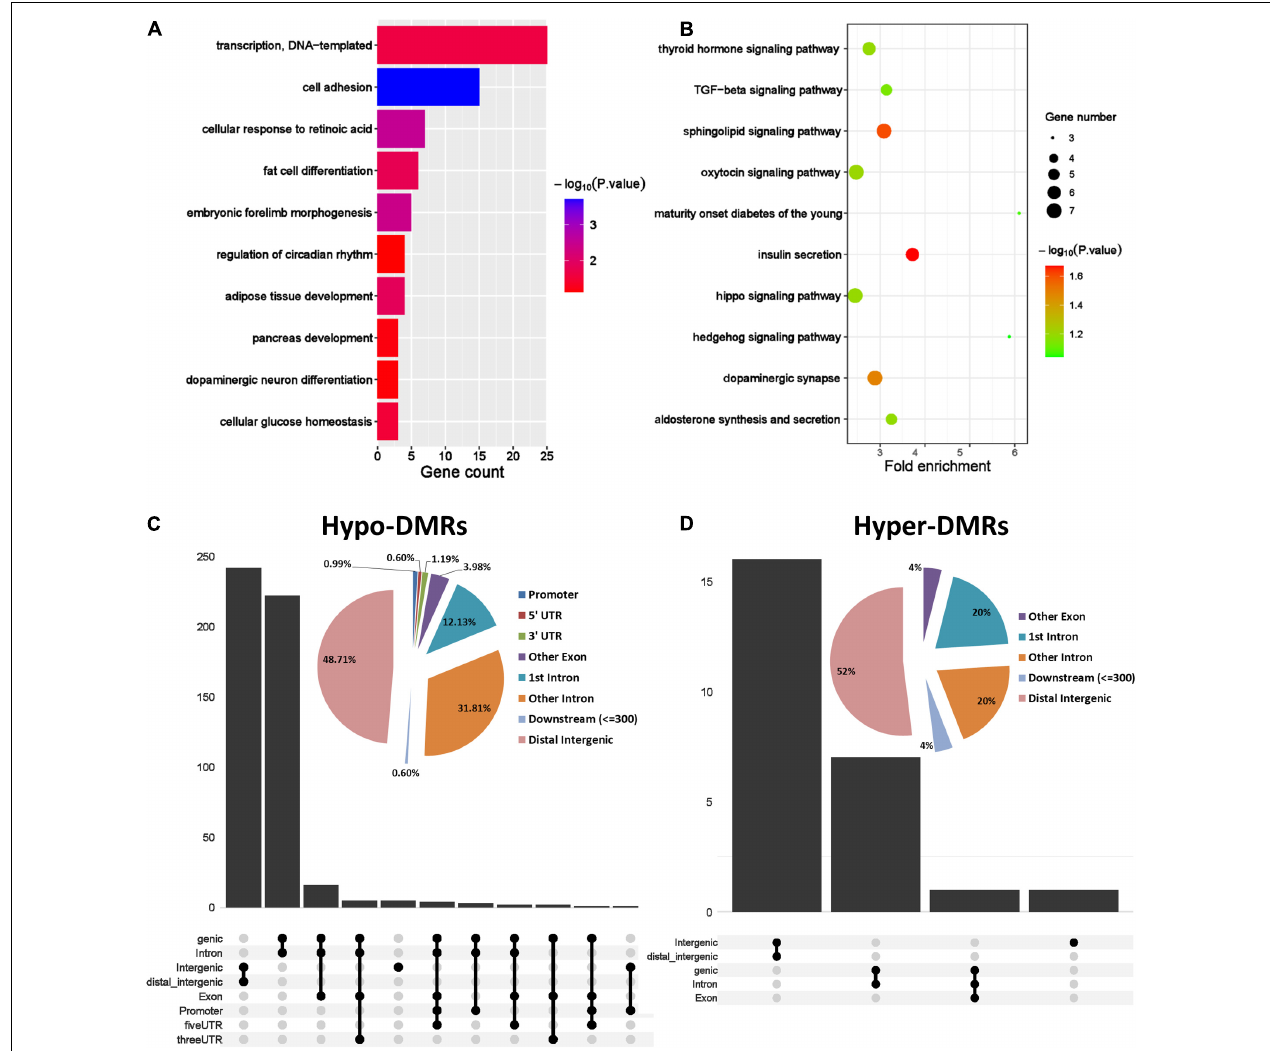
FIGURE 3 | Genomic region preference and functional analysis of DMRs. (A) GO term analysis of hypo DMRs in GCs obtained from PCOS and control ovaries. (B) KEGG analysis of hypo DMRs in GCs obtained from PCOS and control ovaries. (C,D) Genomic distribution of the hypo DMRs and hyper DMRs. Pie charts represent proportion of DMRs in different genomic contexts. Upset graphs represent the number of DMRs distributed in single or combined genomic regions.